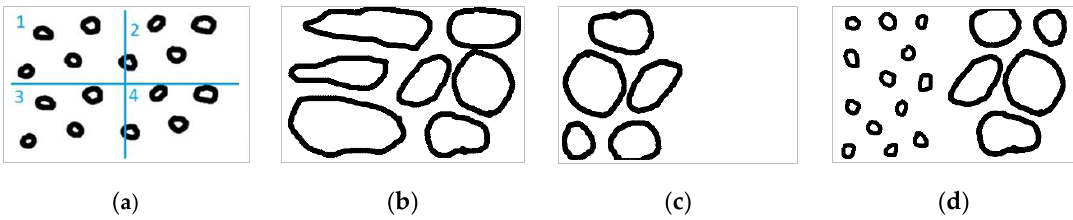
Figure 5. An example of artificially generated sketches with different porosity distribution: porosity created by small pores ( a ), porosity created by large pores ( b ), porosity created by large pores next to the lack of porosity ( c ) porosity created by small pores next to high porosity created by large pores ( d ). Additionally, on figure ( a ) a division into main Regions of Interest (ROIs) is shown.